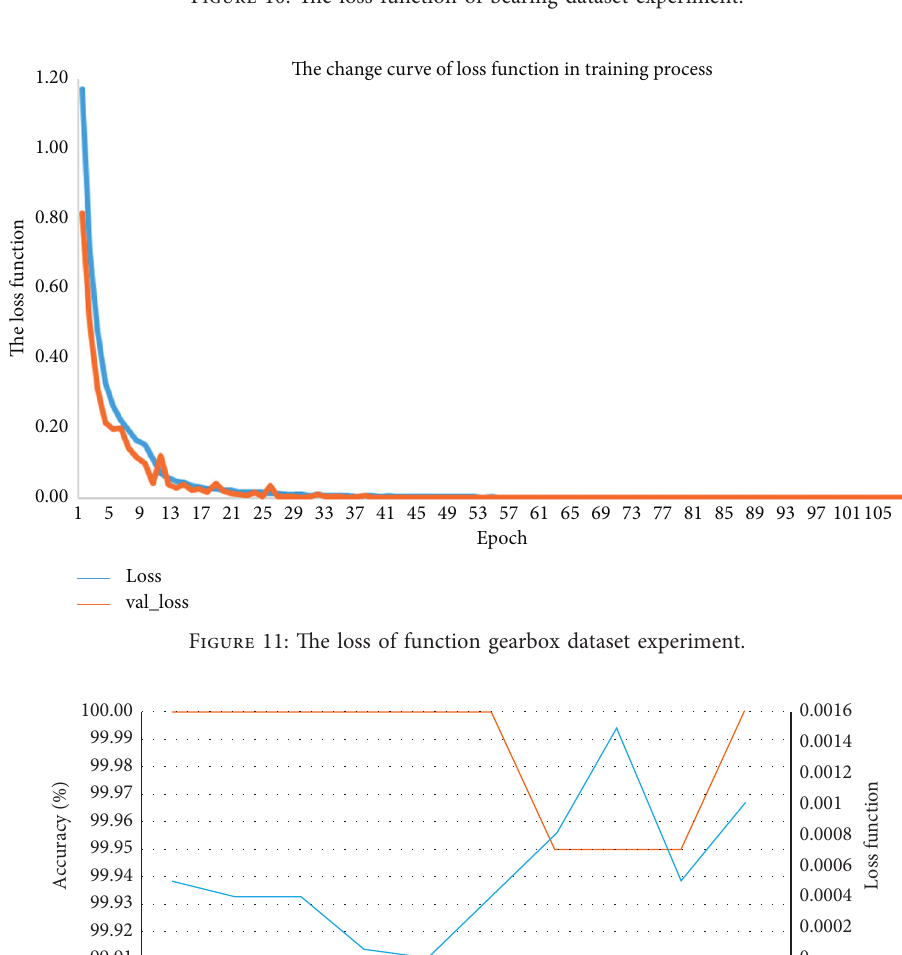
Figure 12: Ten-fold cross-validation result of gearbox